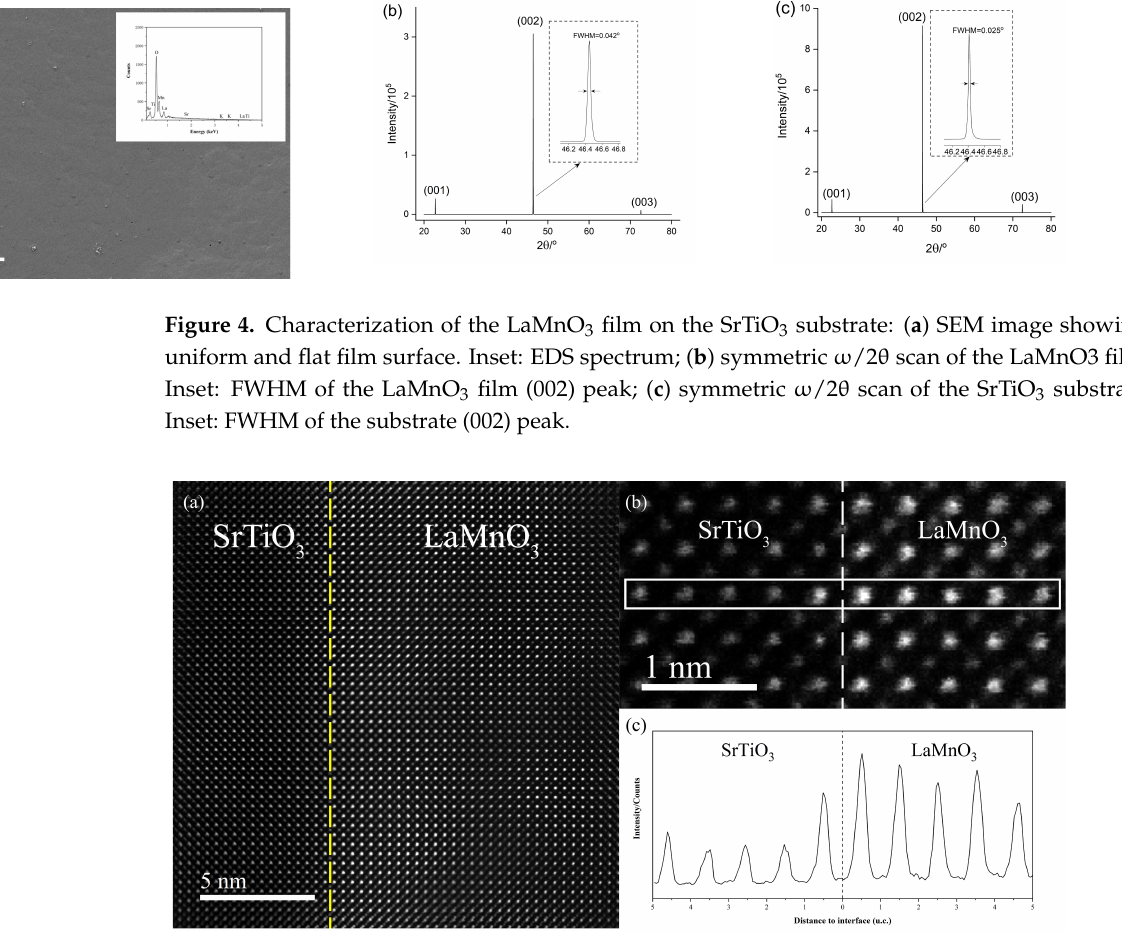
Figure 5. ( a ) ADF-STEM images of the interfaces between LaMnO 3 films and the SrTiO 3 substrate. Yellow dotted lines indicate the positions of the atomically sharp interface; ( b ) ADF − STEM images of the cross-section of LaMnO 3 films with five unit cells of thickness in the [100] direction; ( c ) pixel intensity profile of an ADF line